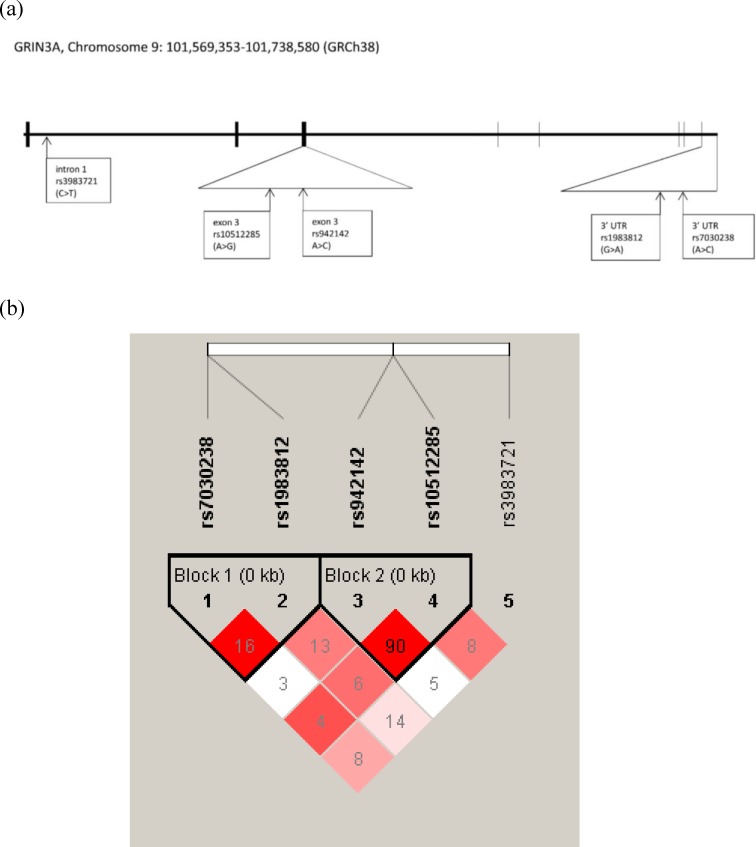
The genomic location and linkage disequilibrium pattern of the GRIN3A genetic polymorphisms included in this study.Genomic locations of the genetic polymorphisms on chromosome 9. Haploview 4.2 software was used to estimate the linkage disequilibrium blocks. The R2 values were shown in squares; range from 0.03 to 0.90 and higher values indicate higher degree of correlation.